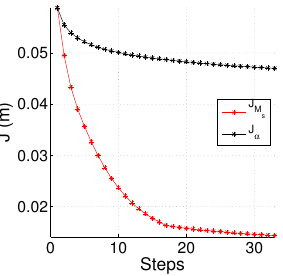
Fig.6. EvolutionofthecostfunctionJduringtheinversionof M s (inred)andtheinversionof α (in black),over35iterations. Figure 6. Evolution of the cost function J during the inversion of M s (in red) and the inversion of α (in black), over 35